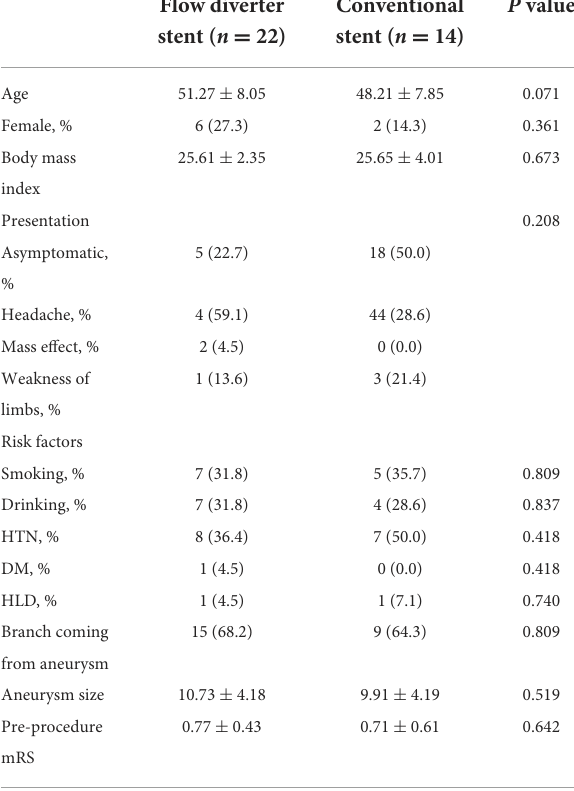
TABLE 1 Patient and aneurysm